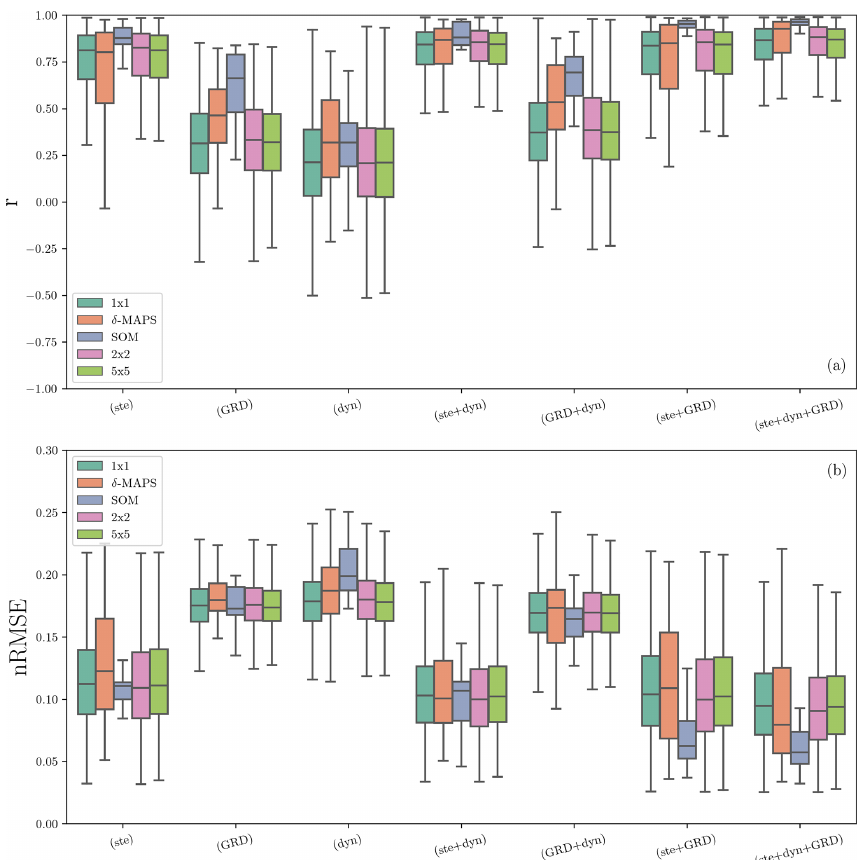
Figure A7. Same as Fig. 5 but including sea-level budget considering blocks of 2 × 2 and 5 × 5 ◦ . There is no clear improvement from the 1 × 1 ◦ budget to the 2 × 2 and 5 × 5 ◦ , showing the added value of using the δ -MAPS and SOM domains.